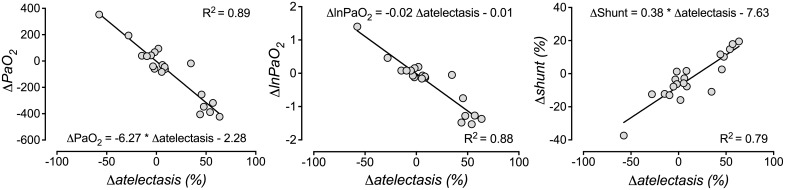
Correlation between changes of oxygenation, shunt and atelectasis in pigs.The differences (deltas) between the two measurement points in pigs (atelectasis in otherwise normal lungs and 12h after induction of ARDS) for PaO2, lnPaO2, shunt and atelectasis were calculated. These repeated measurements were available only for pigs (N = 19). Linear regression of delta-PaO2 (ΔPaO2, left panel), delta-lnPaO2 (ΔlnPaO2, central panel) or delta-shunt (Δshunt, right panel) on the changes in atelectasis (Δatelectasis) was performed. Blood gases were obtained after short-term ventilation with pure oxygen for five minutes. In this figure, atelectasis refers to real atelectasis as well as to the non-aerated lung tissue after induction of ARDS and was quantified as percentage of Mtotal (-100 to 100 HU in computer tomography). Intrapulmonary (Berggren’s) shunt was calculated according to [28]. We transformed PaO2 values logarithmically (lnPaO2) to linearize the relationship between PaO2 and atelectasis.